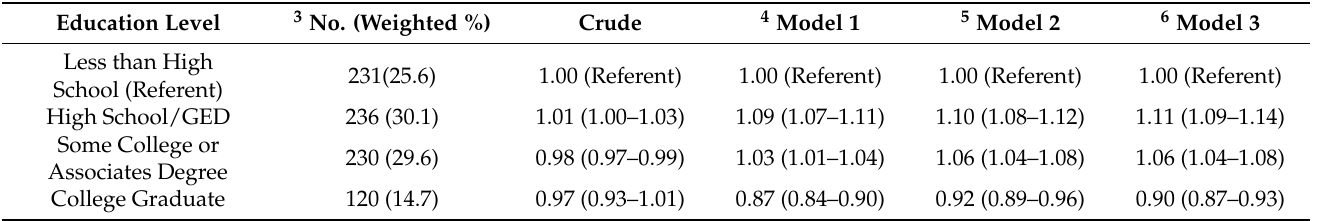
Table 2. Prevalence ratios (PRs) 1 and associated 95% confidence intervals (CIs) to examine the association between education and high allostatic load prevalence with National Health and Nutrition Examination Surveys (NHANES), 1999–2018 ( n = 4113) 2 .